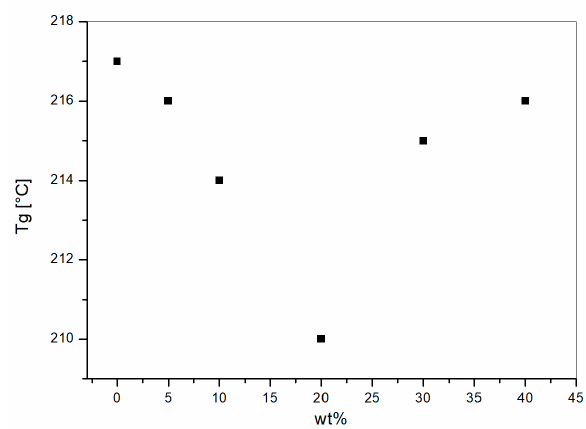
Figure 8. Glass Transition Temperature (Tg) versus PC content for the PEI rich phase (data extrapolated from peak analysis of Figure 6).